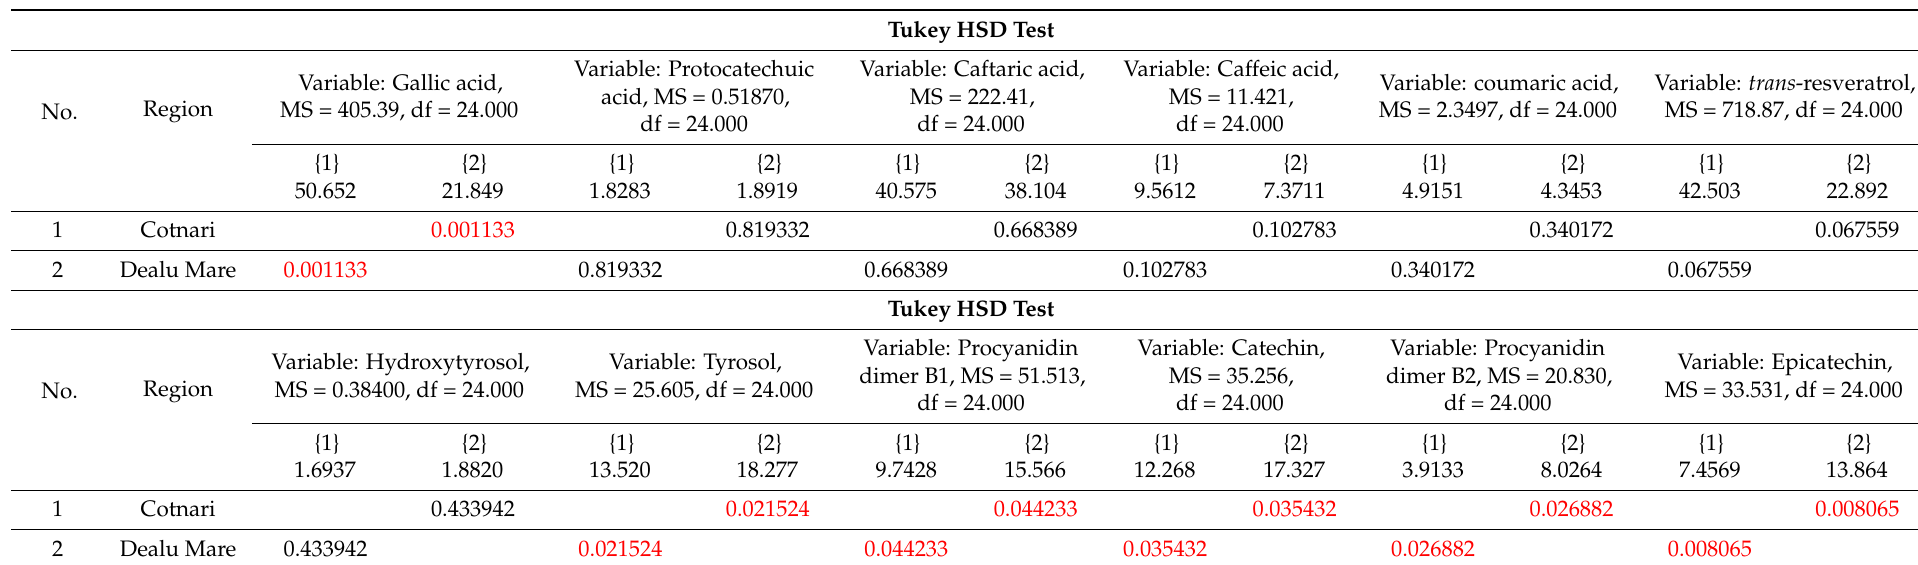
Table 5. Tukey HSD test